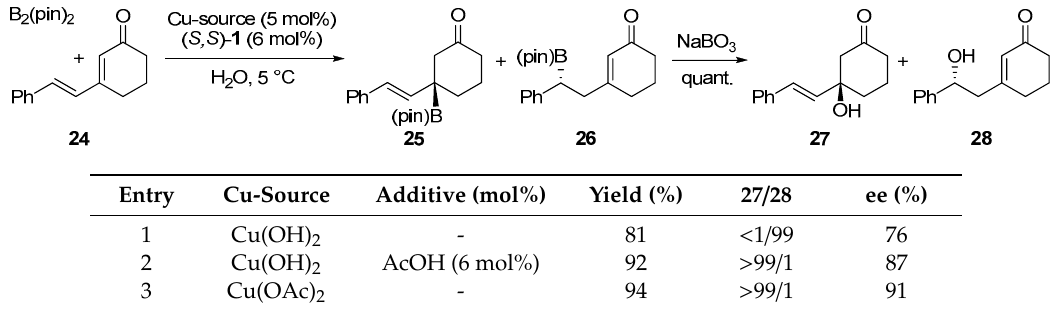
Table 6. Conjugate addition of B 2 (pin) 2 to cyclic dienone 24 .